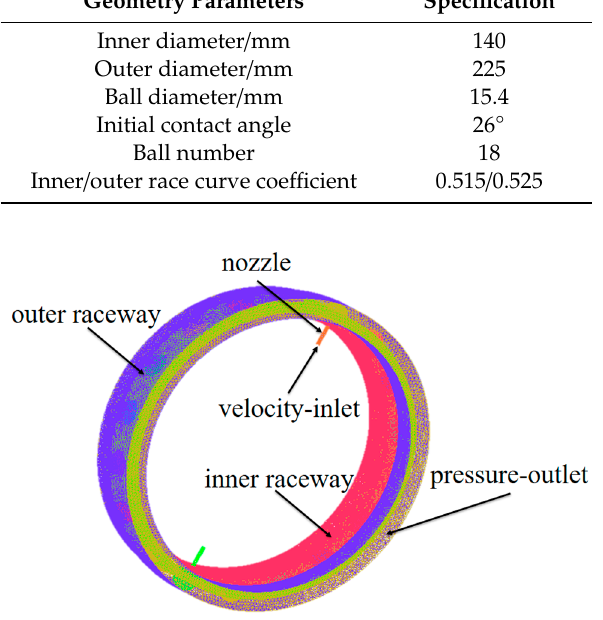
Figure 2. Computational mesh structure.